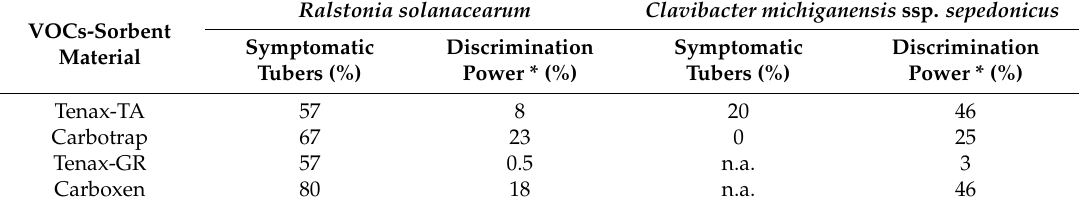
Table 3. Performances of PEN3 e-nose equipped with different VOCs-sorbent cartridges (provided with electronic desorption unit, EDU3 (Airsense Analytics GmbH, Germany) in terms of ability to discriminate healthy from symptomatic potato tubers, infected by Ralstonia solanacearum or Clavibacter michiganensis ssp. sepedonicus . The percentage of symptomatic tubers, detected by conventional molecular diagnostic analysis (EU Directive 2006 \ 56 \ CE) at the end of sensorial analysis, in the bulk sample is also reported (n.a. = not